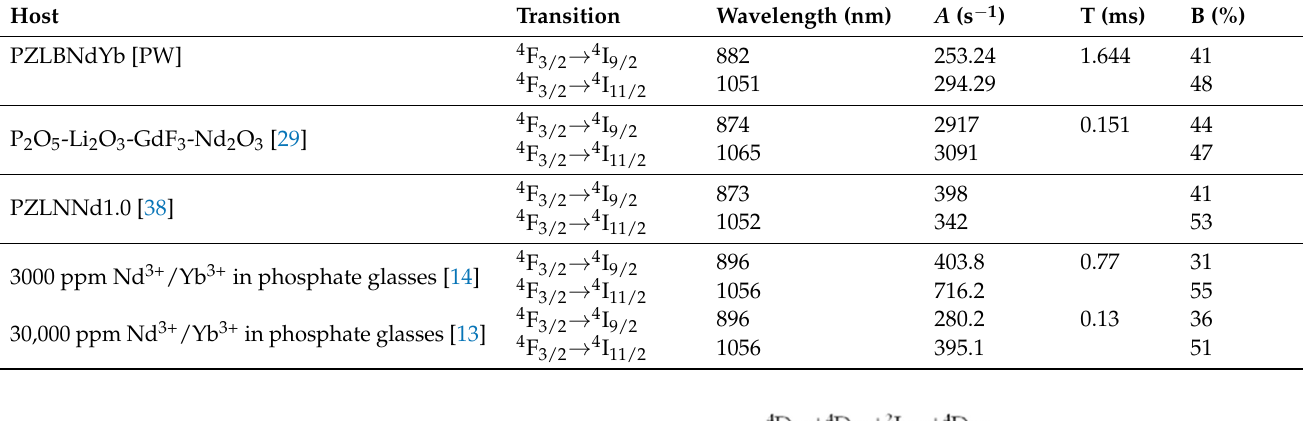
Table 4. Peak position ( λ , nm), radiative transition probabilities ( A , s − 1 ), calculated branching ratios ( β ) and radiative lifetime ( τ , ms) for 4 F 3/2 → 4 I 9/2 and 4 F 3/2 → 4 I 11/2 transitions of Nd 3+ -doped phosphate glasses.